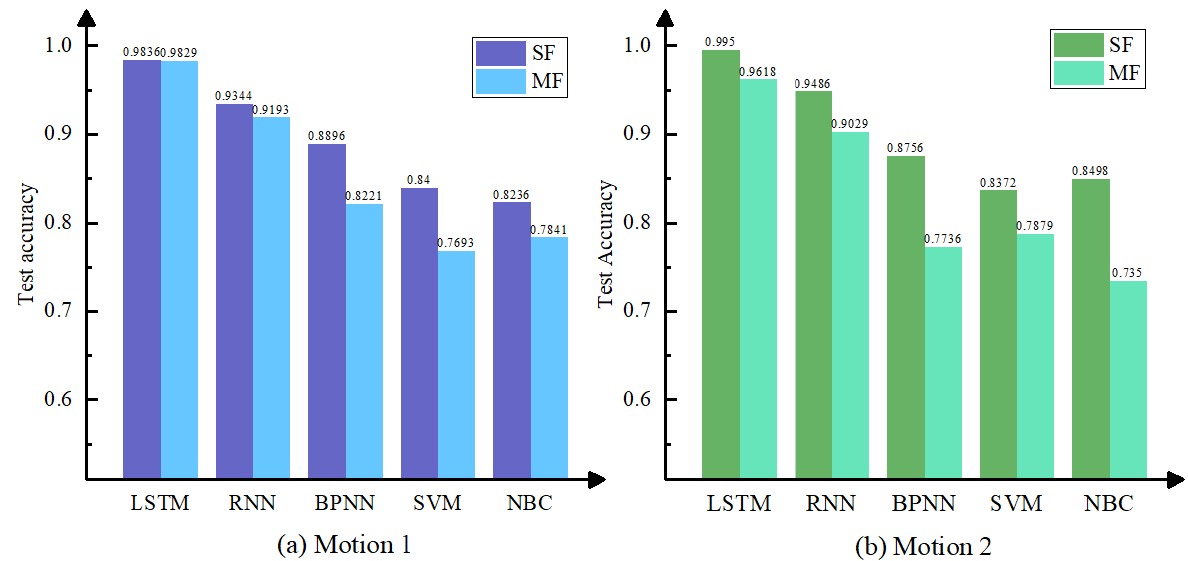
Figure 11. Comparisons of recognition accuracies in the first stage. ( a ) Motion 1; ( b ) Motion 2.